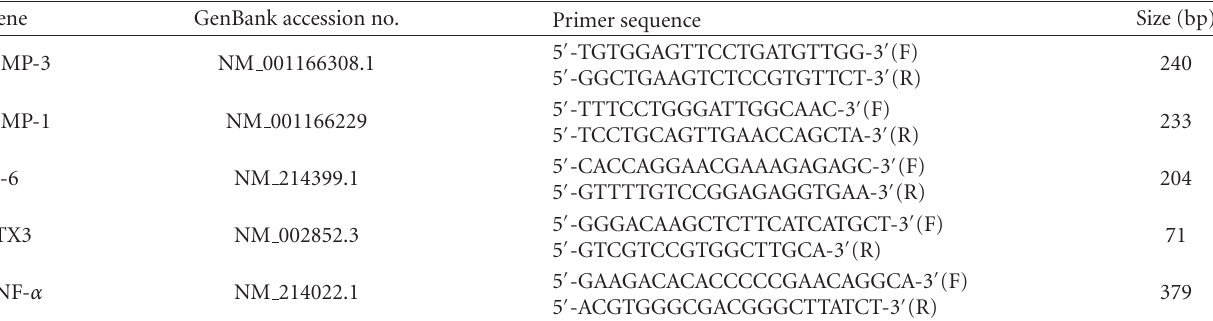
Table 1: Primer sequences used for